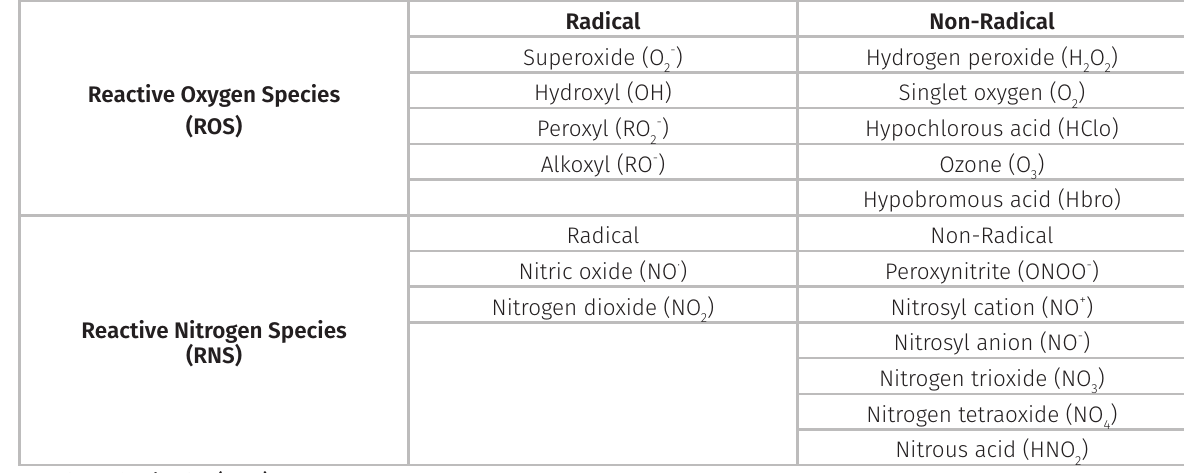
Table I. Reactive oxygen species and reactive nitrogen